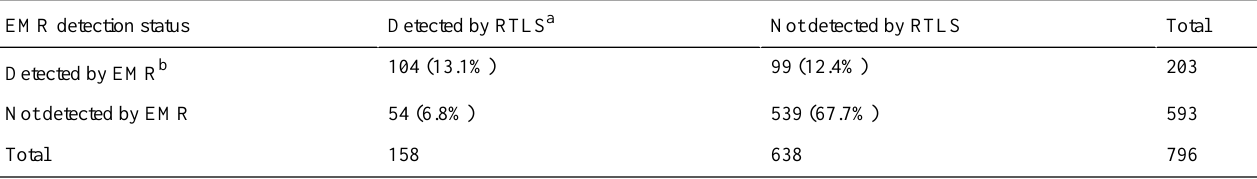
Table 1. Summary of possible contacts identified by the RTLS and EMR over 34 patient days. Percentages are calculated according to row values.